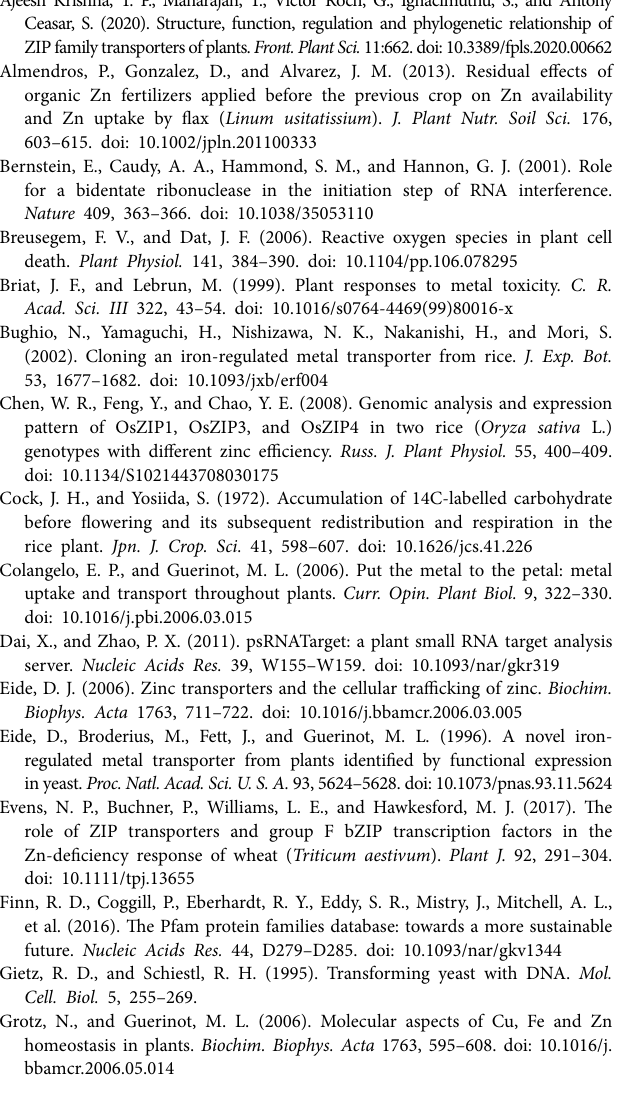
Supplementary Figure S3 | Expression patterns of three ZIP genes under Zn- and Fe-deficient conditions. Seedling two leaf of Xiaobaimai shoots (S) and roots (R), under standard nutrient condition (CK), Zn-, Fe-deficiency treated, were harvested, respectively, at 0, 6, and 12 h, after treatment. (A) Treat with Zn-deficiency; (B) treat with Fe-deficiency. Data from real-time RT-PCR experiments were analyzed according to the 2 −∆∆ C t method. Relative mRNA abundance of each gene was normalized with TaActin gene. The error bars indicate standard